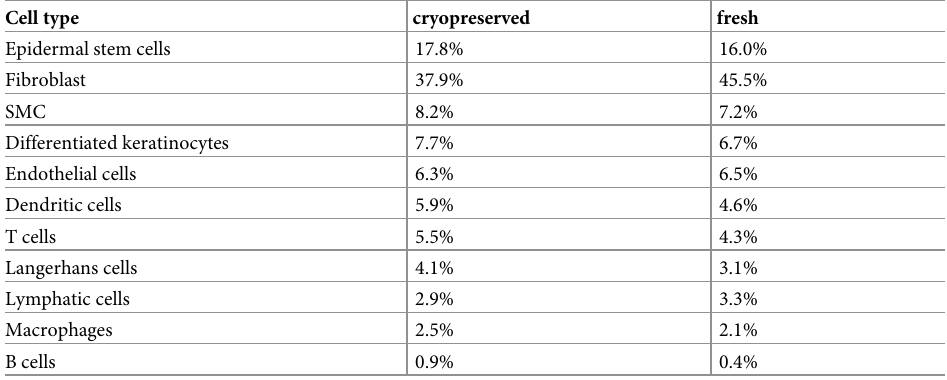
Table 1. Cellular composition in fresh and cryopreserved samples.